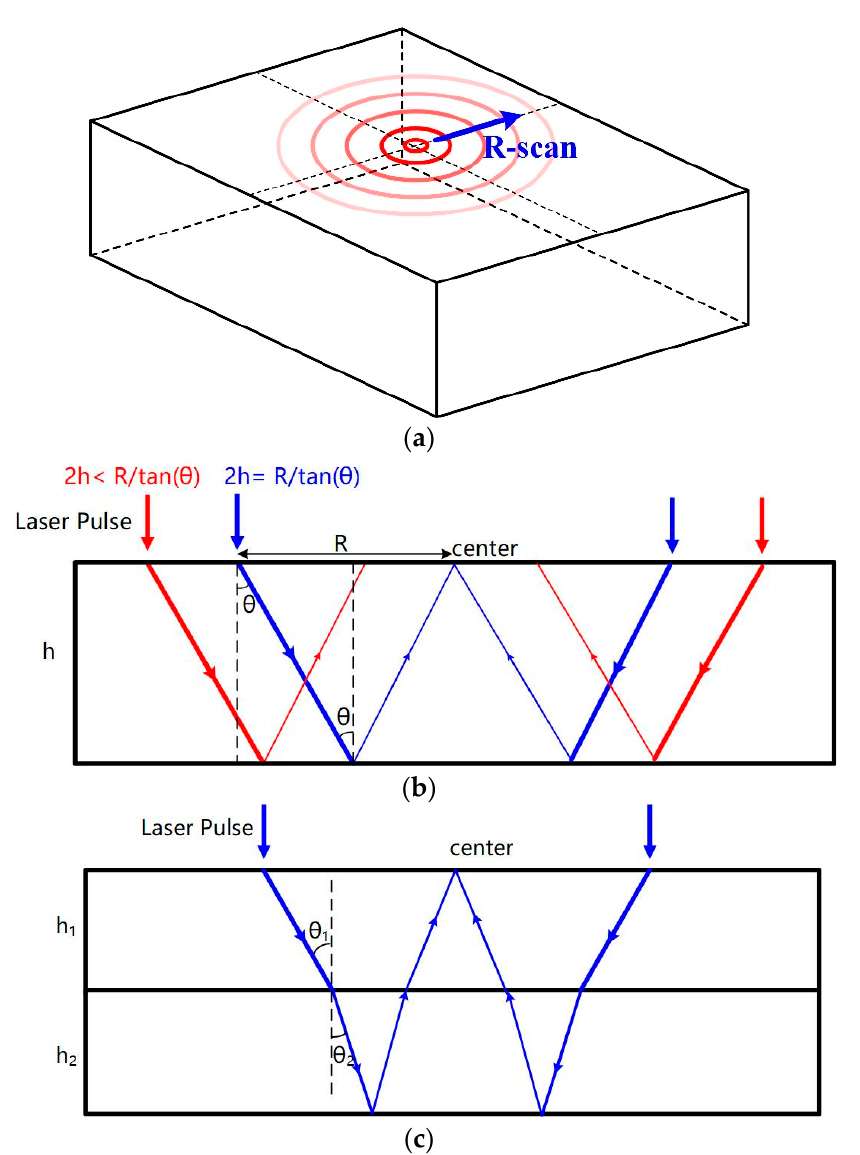
Figure 3. Schematic diagram of ( a ) ring-shaped laser irradiation and cross-sectional view of wave propagation in ( b ) a single-layer material and ( c ) a bi-layer material.